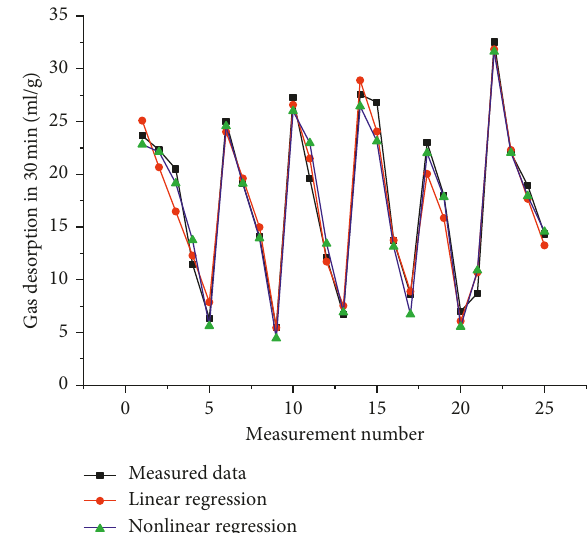
Figure 3: Comparison of the multivariate quadratic regression and multivariate one-time regression